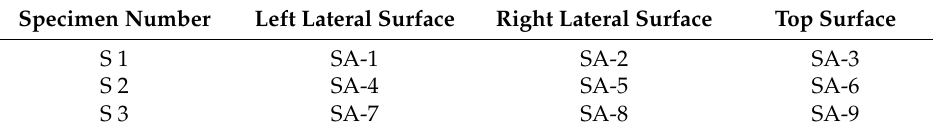
Table 1. The groups of specimens.